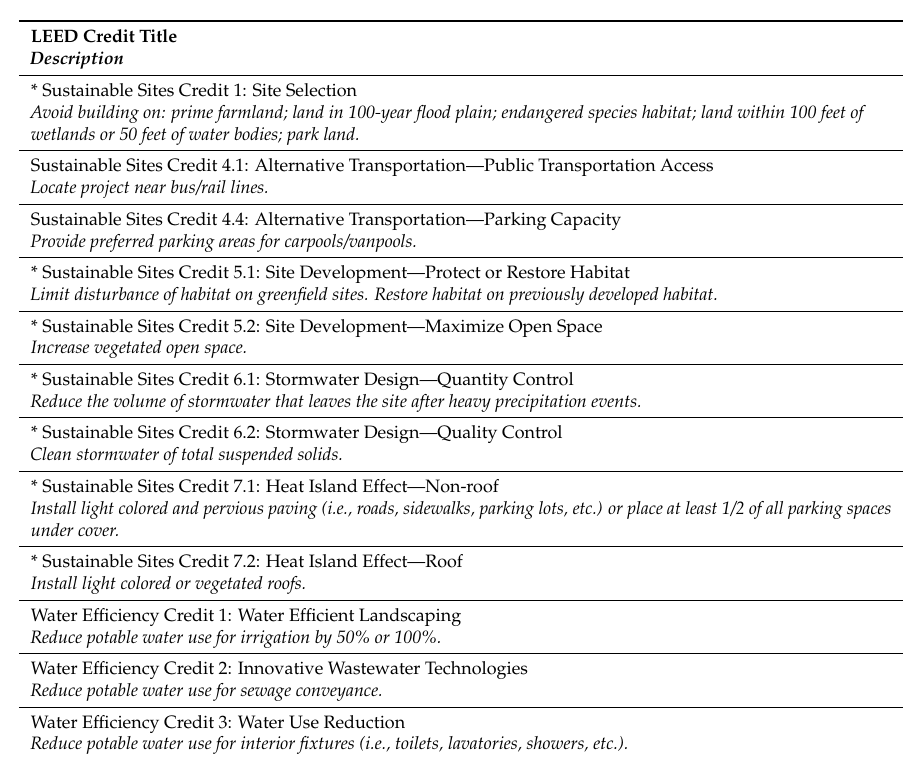
Table 2. LEED credits included in flooding resilience literature